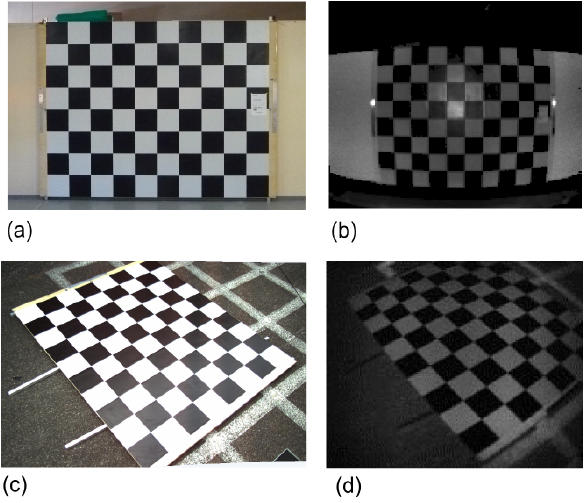
Figure 7. Photographs of the calibration checkerboard installed indoors (a) and outdoors (c); corresponding amplitude images output by the SR4500 indoors (b) and